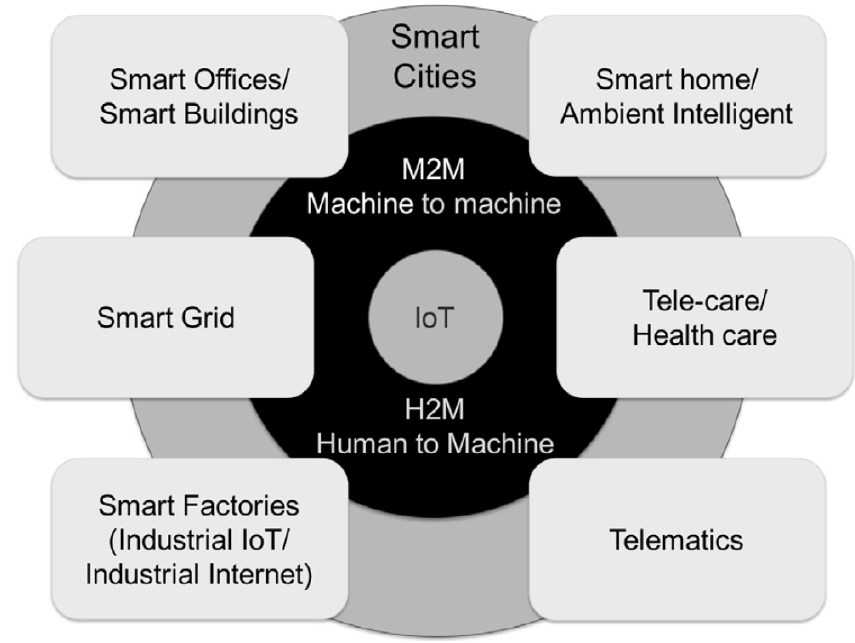
Figure 4. Typical architecture of a smart city adapted with permission from Ref. [58] .